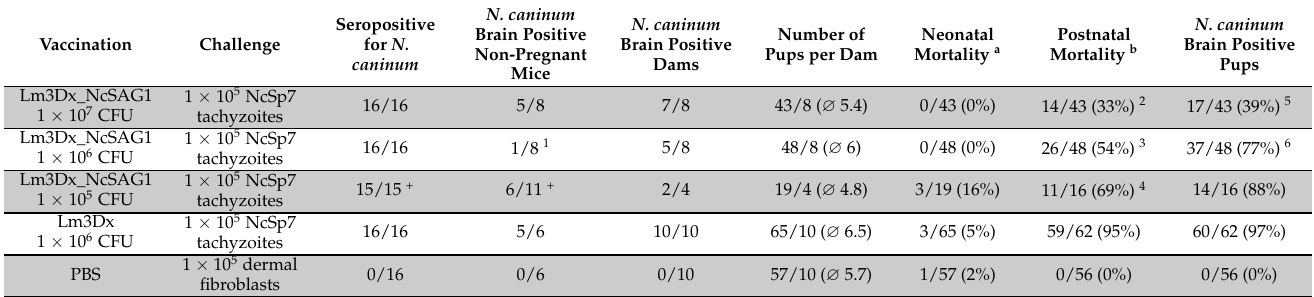
Table 1. Serology, parasite burden, litter size, neonatal and postnatal mortality rates of N. caninum infected mice vaccinated three times with the attenuated mutant Listeria monocytogenes strain Lm3Dx_NcSAG1 at different dosages. Animals in the vaccinated groups were compared with the positive control group by the Chi-square (and Fisher’s exact) test.